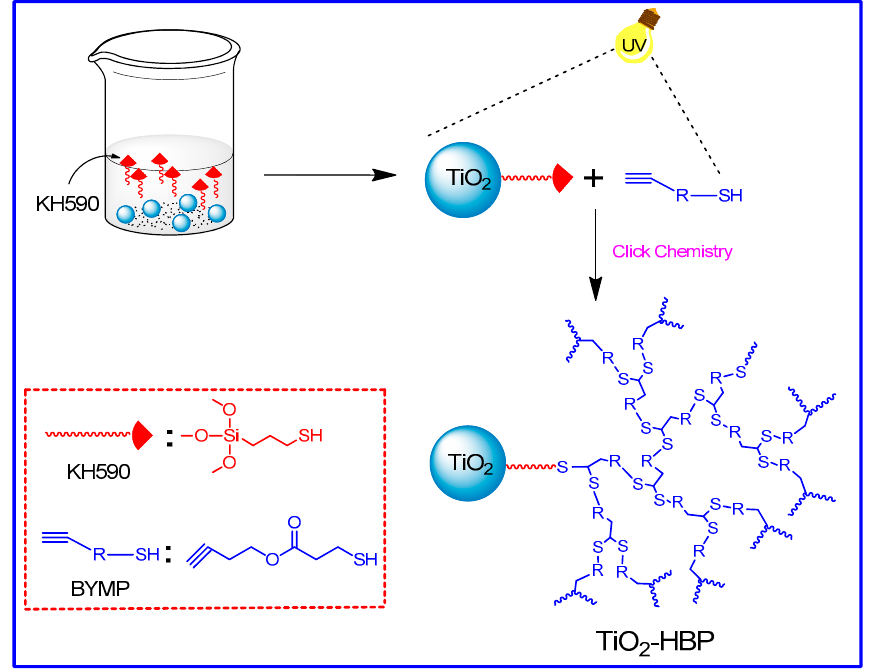
Figure 1. Synthetic route of TiO 2 nanoparticles grafted with hyperbranched polymers (TiO 2 -HBP).